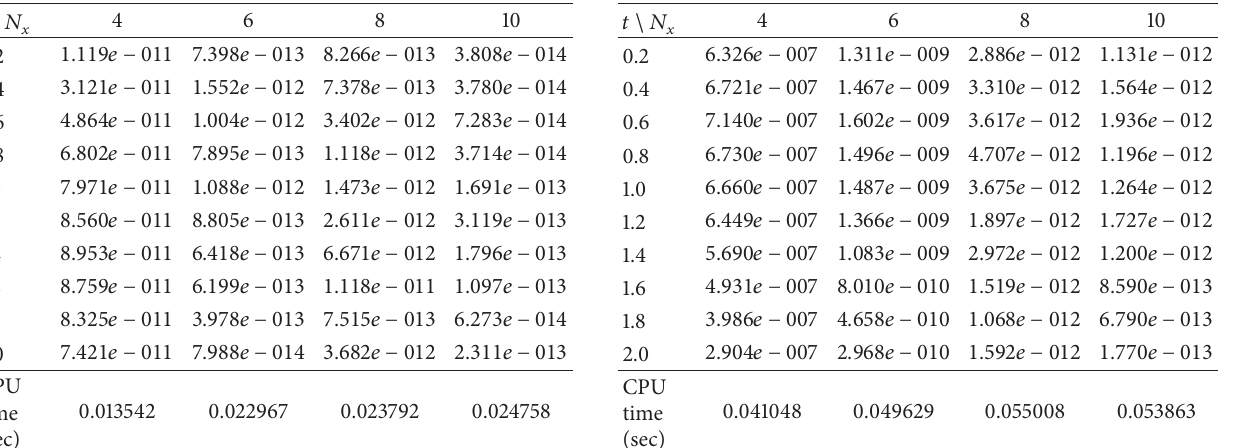
Table 7: Maximum errors 𝐸 𝑁 for Fisher equation when 𝛼 = 1 using = 10 . 𝑁 𝑡